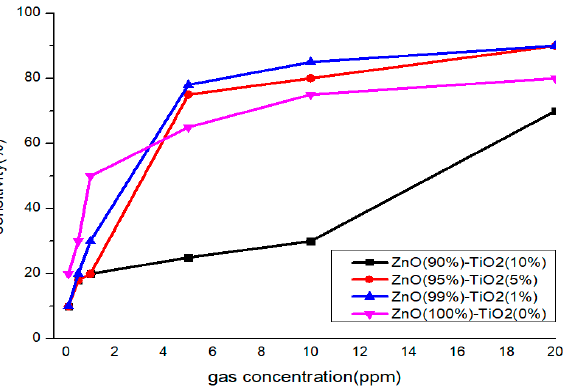
Figure 9. Sensitivity characteristics by concentration of formaldehyde gas of gas sensor by TiO 2 ra- tio. Table 2. Summary of sensor characteristics for formaldehyde gas by sensor.